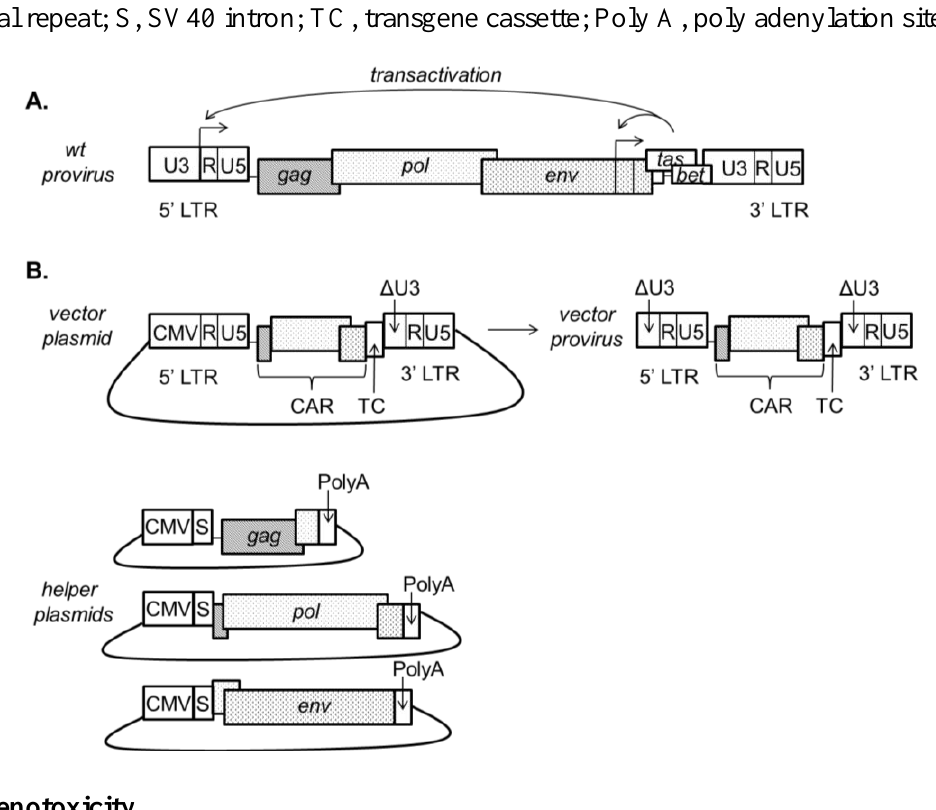
Figure 2. ( A ) Wild type FV provirus; ( B ) A third generation minimal FV vector backbone and helper plasmids. The vector is shown as it would appear in a plasmid for vector production and as an integrated provirus. Third generation FV vectors include a deletion of the transcriptional transactivator, tas (Previously known as bel-1 ), which acts at the viral LTR in wild type FV. These vectors are SIN due to the removal of the transactivator tas and have a deletion encompassing the TATA box and enhancers in the U3 region of the 3' LTR of the vector plasmid (ΔU3 in figure). This deletion is copied to the 5' end of the viral genome during reverse transcription, resulting in the silencing of both LTRs in the integrated provirus. In contrast to LV vector systems, gag and pol in FV vector systems are translated from separate mRNAs, and gag , pol and env genes are provided in trans on three separate helper plasmids. Cis -acting regions (CAR) remain on the vector